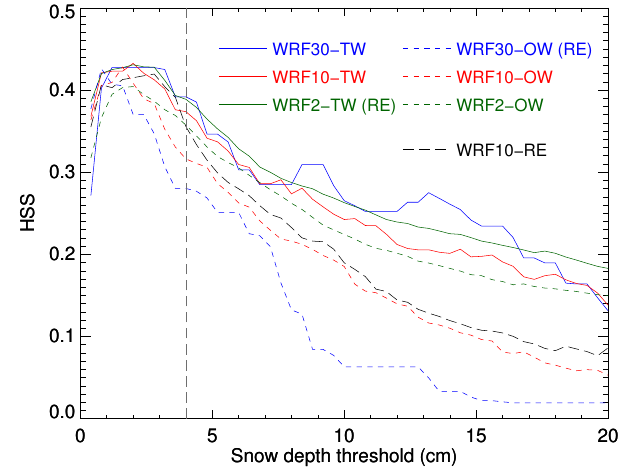
Fig. 7. Sensitivity to the nesting strategy: HSS curves for snow depth predicted by WRF simulations (TW, OW and RE) at all resolutions for thresholds between 0.2 and 20cm, with respect to snow extent observed by MODIS on the SD.